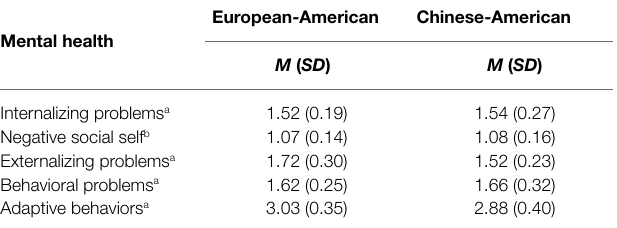
TABLE 2 | Means and standard deviations of mental health variables by culture.